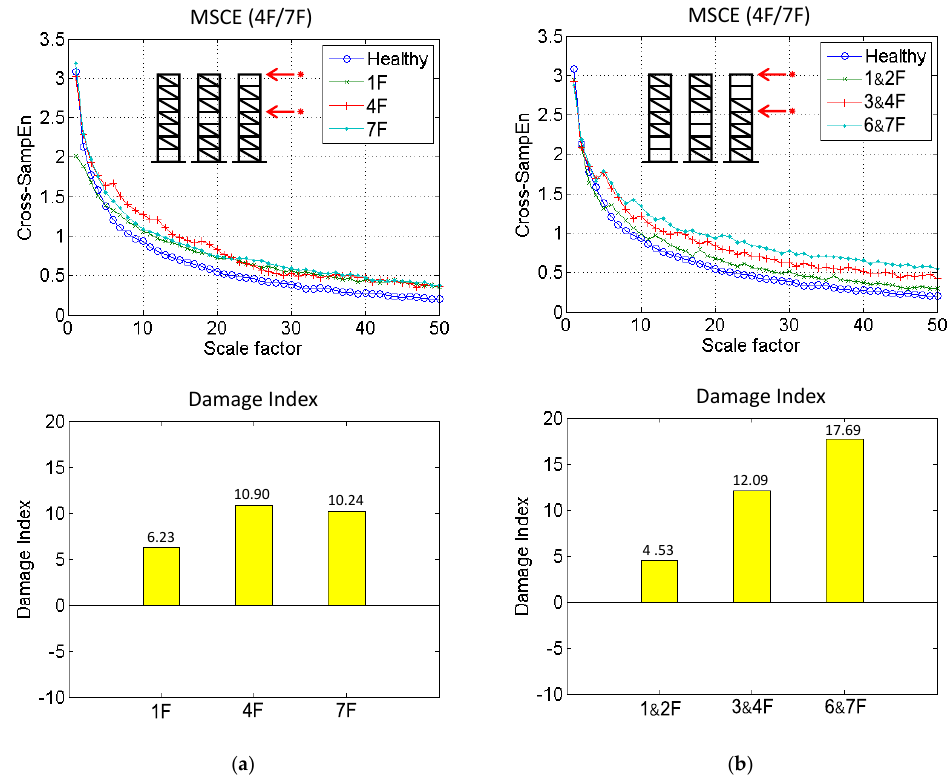
Figure 5. Multiscale cross-sample entropy (MSCE) and damage index (DI) diagrams of ( a ) single-story and ( b ) two-story damage.